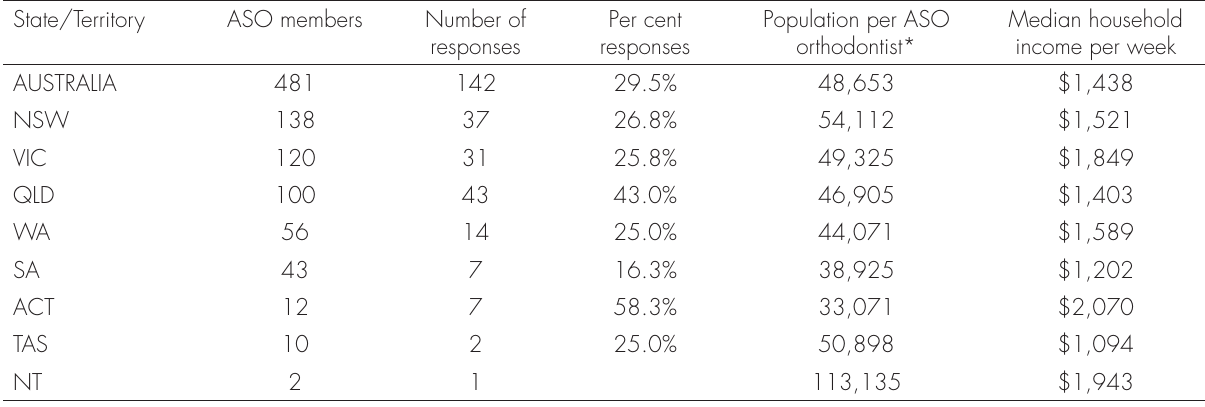
* Based on population from 2016 Australian census